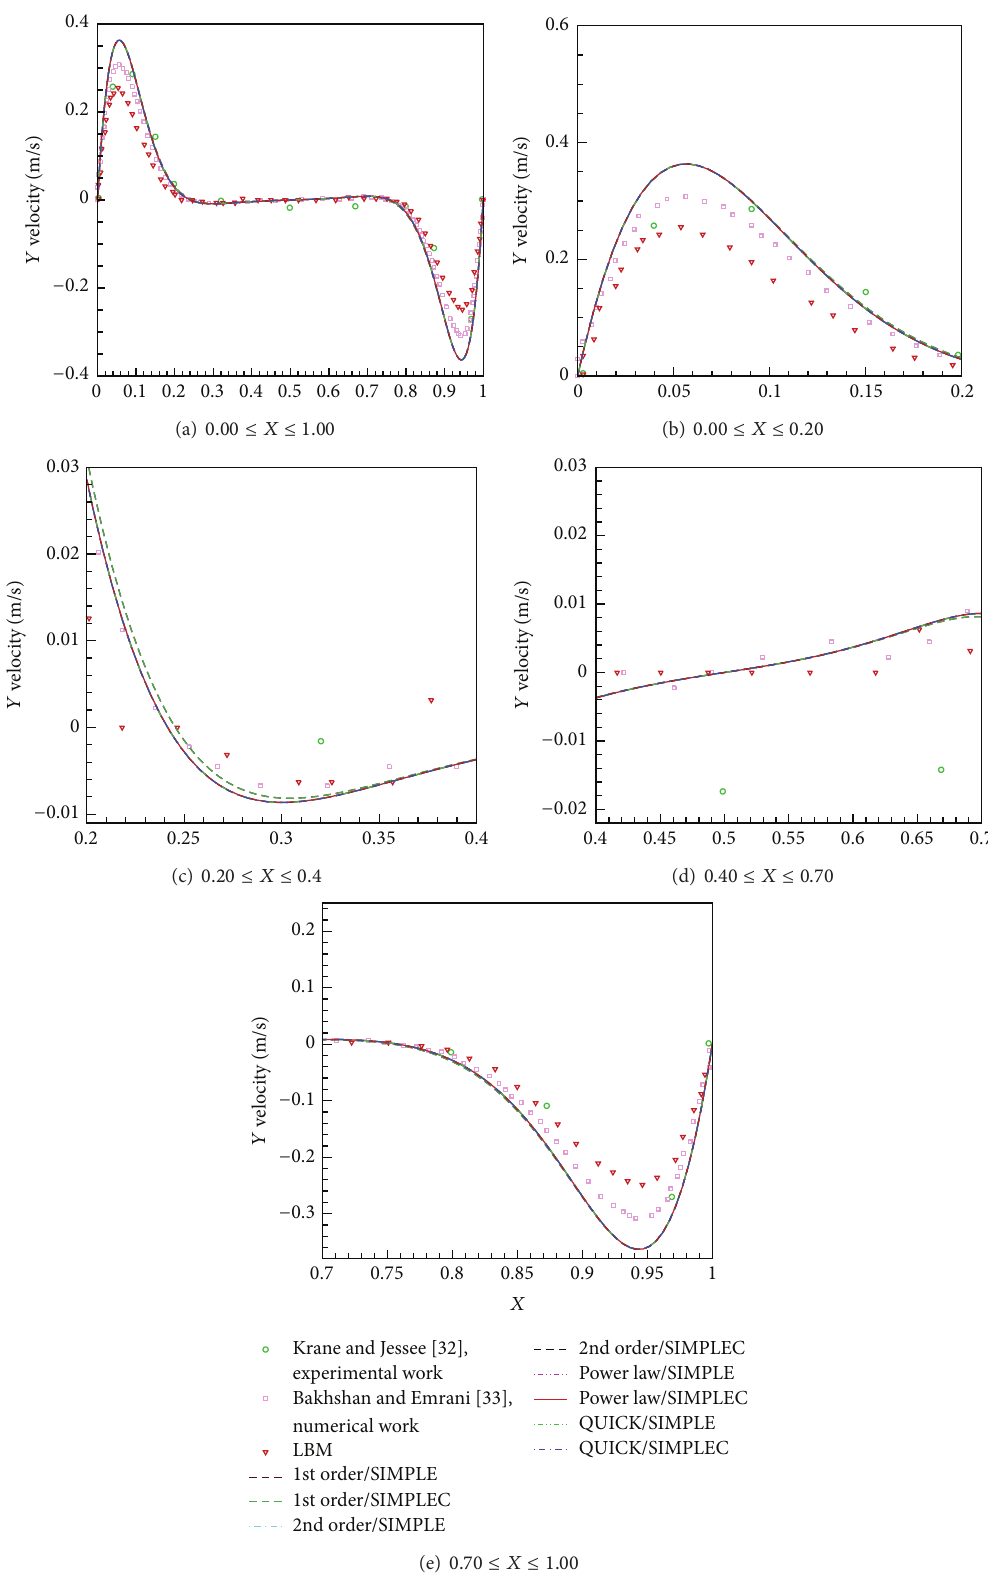
Figure 3: Vertical velocity profile at